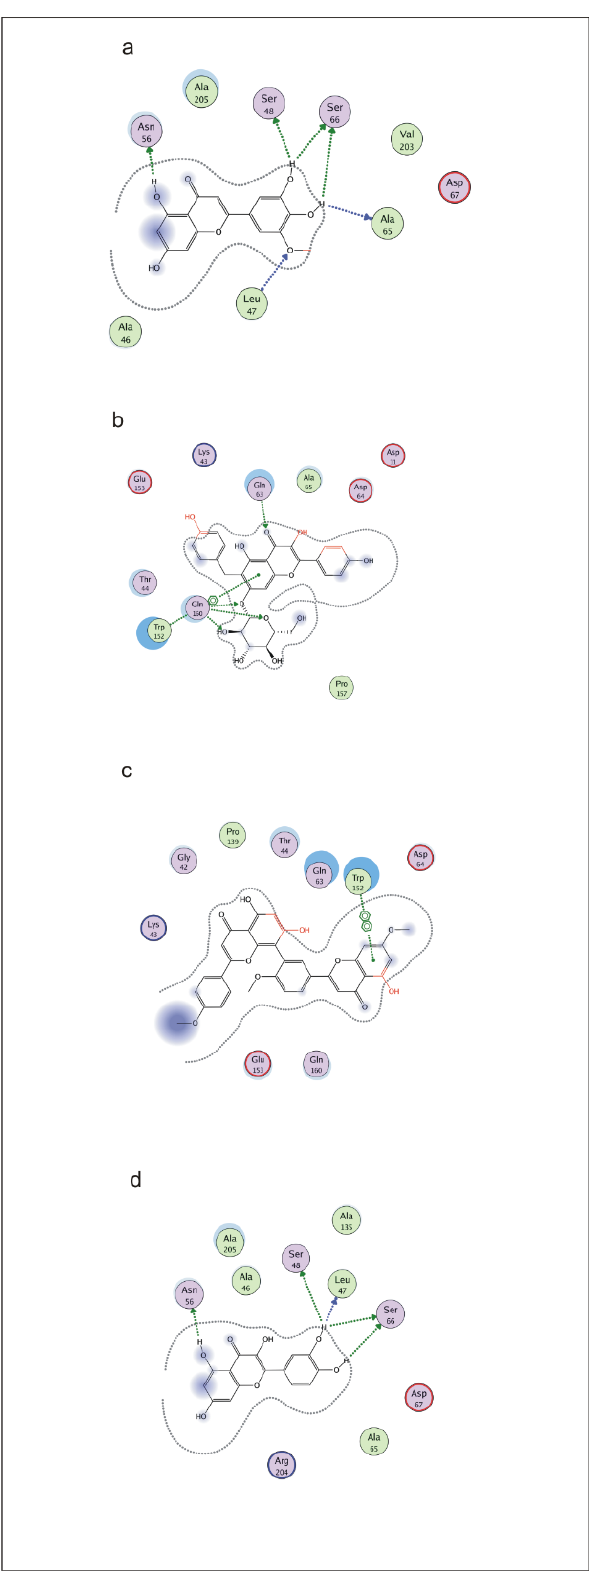
Figure 9. Two ‐ dimensional interaction view of flavonoid atoms with specific residues in active site of V protein. Here, dots are showing specific interactions with ( a ) swertifrancheside, ( b ) 3 ′‐ O ‐ methyltricetin, ( c ) 7 ‐ O ‐β‐ D ‐ glucoside kaempferol, and ( d ) 7,4 ′ ,4 ′″‐ trimethyl ether amentofla ‐ vone.